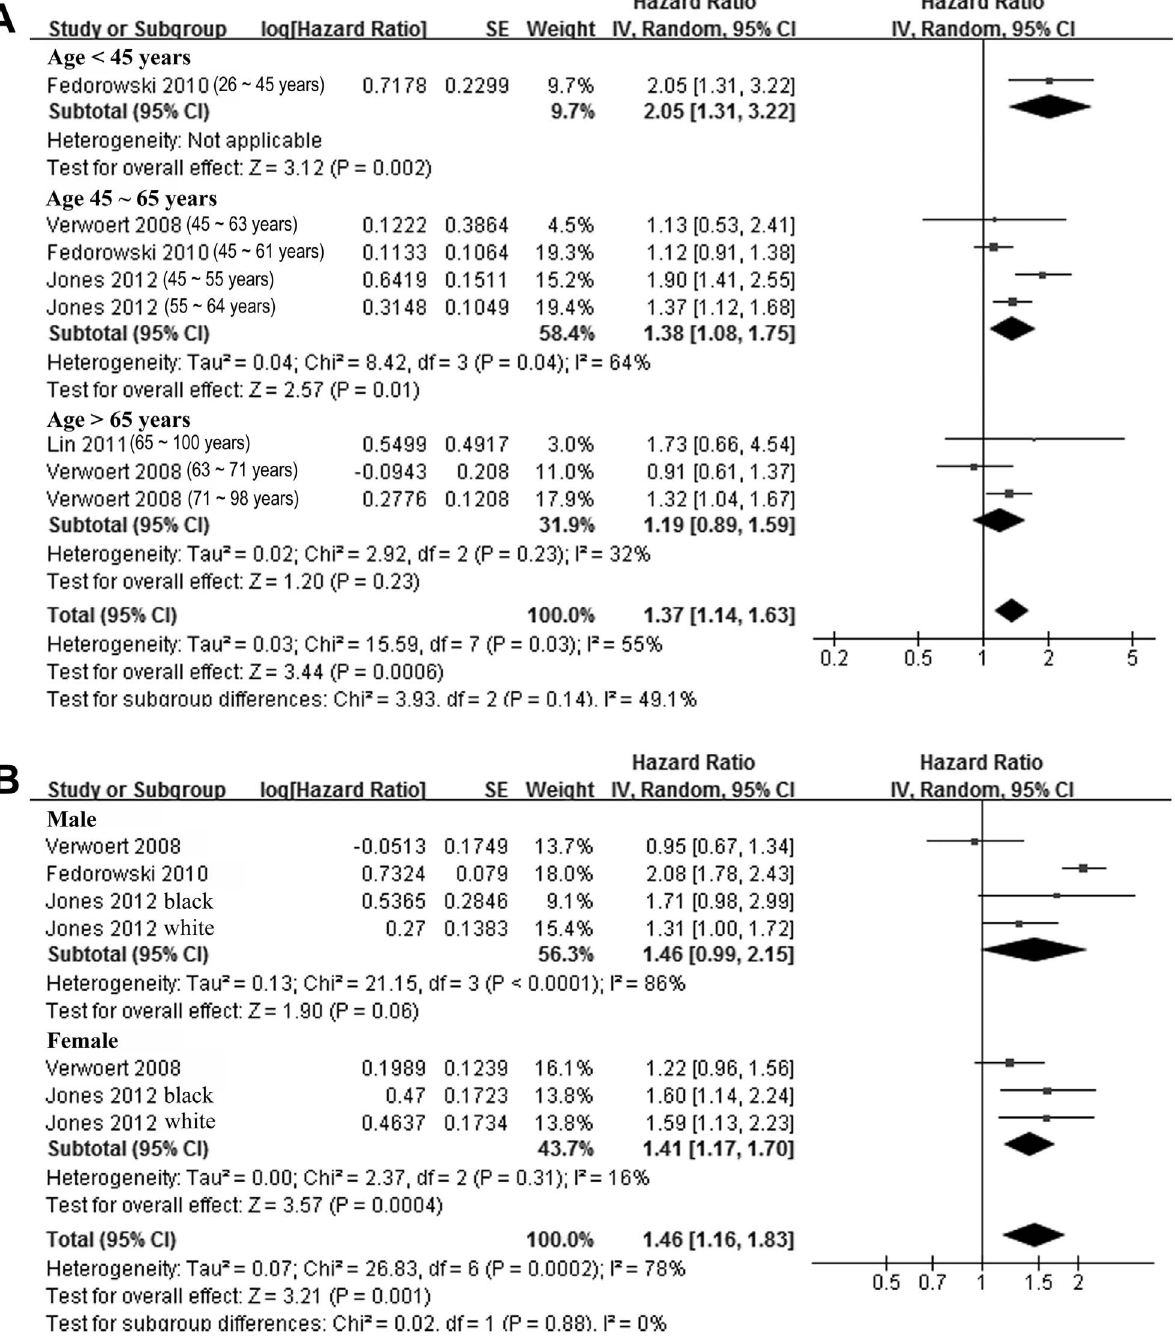
Figure 3. Adjusted hazard ratio of congestive heart failure in subjects with orthostatic hypotension at baseline compared those without orthostatic hypotension stratified by the age ranges (A) and gender (B) of the subjects. CI, denotes confidence interval; the size of each square is proportional to the study’s weight (inverse of variance – IV).